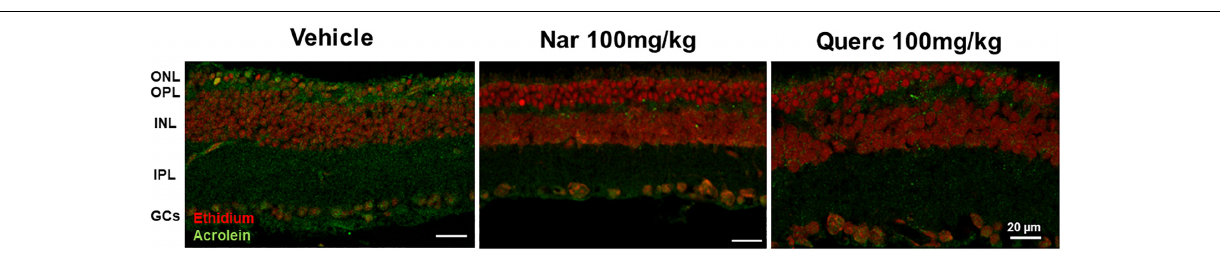
FIGURE 5 | Lipid peroxidation in rd10 mouse retina. Immunolabeling of acrolein (green staining), a toxic product formed during lipid peroxidation and used as a marker of oxidative stress, is reduced after treatment with naringenin or quercetin for 27 days as compared with control. ONL, outer nuclear layer; OPL, outer plexiform layer; INL, inner nuclear layer; IPL, inner plexiform layer; GCs, ganglion